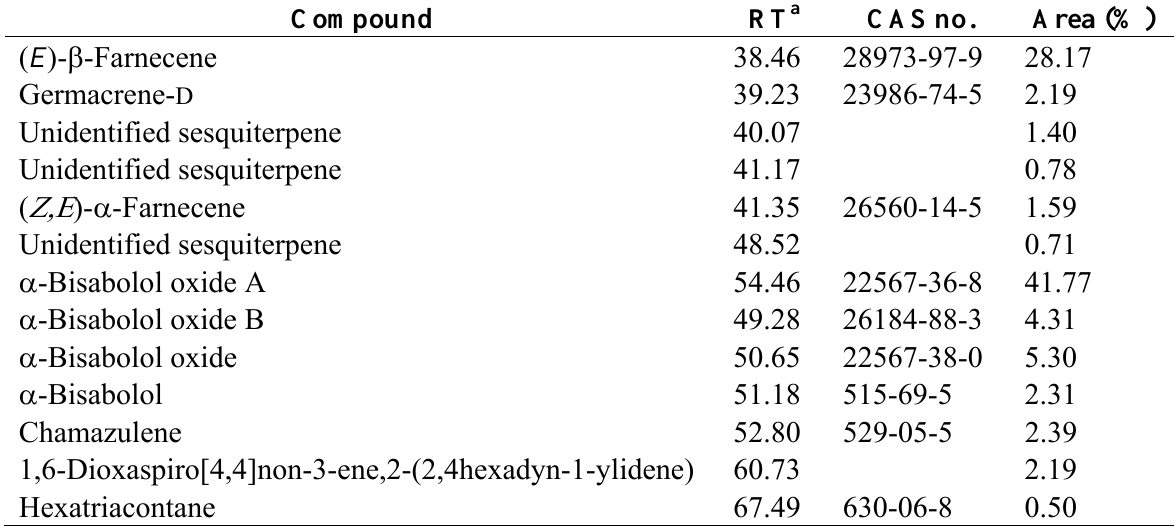
Table 1. Components of the tested chamomile essential oil